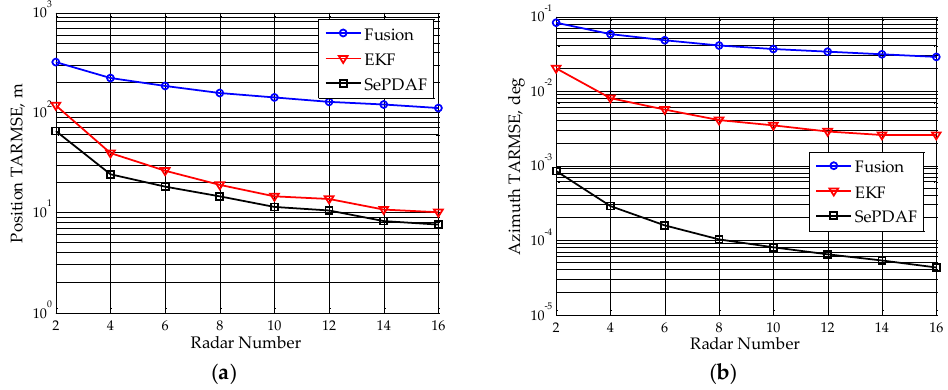
Figure 5. TARMSEs under different sub-radar number after using the proposed method: ( a ) position RMSE; and ( b ) azimuth RMSE.